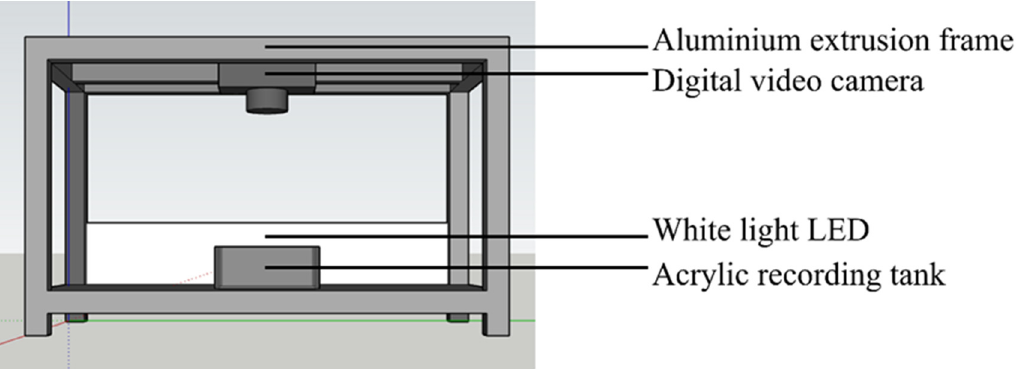
Figure 1. Diagram of the experimental setup showing the position of the recording tank and the overhead